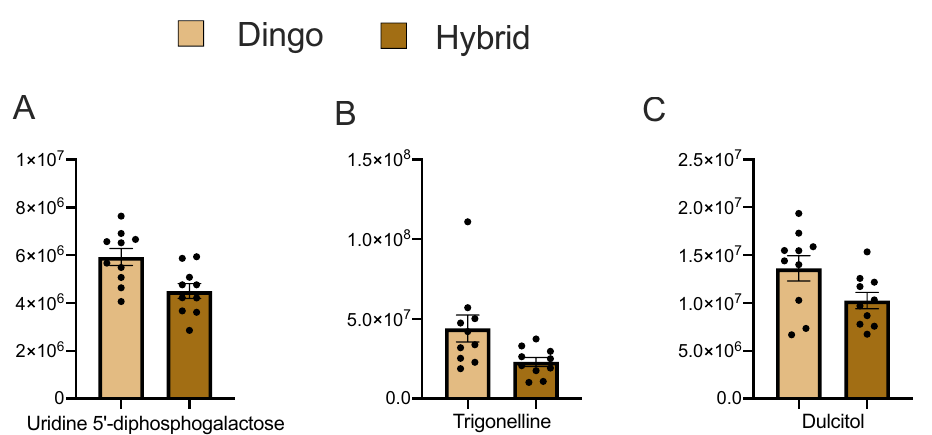
Figure 4. Metabolite difference between the dingo and dingo-domestic dog hybrid. Y axis represents normalised area for the metabolite. Plot show mean with